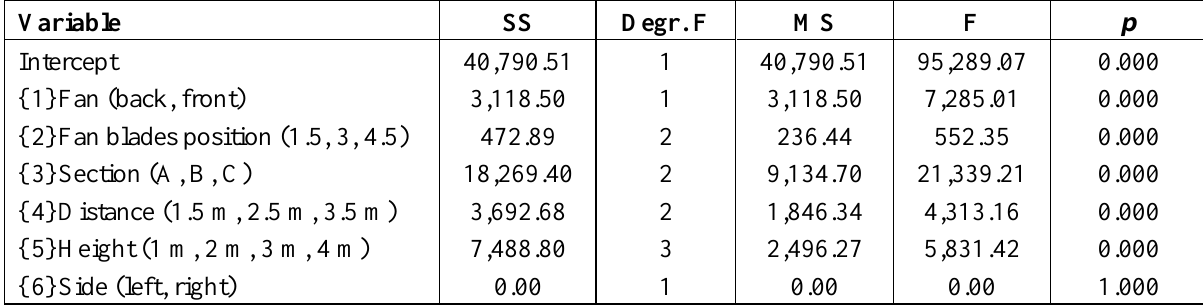
Table 2. Univariate test of significance for the velocity air in the static test.